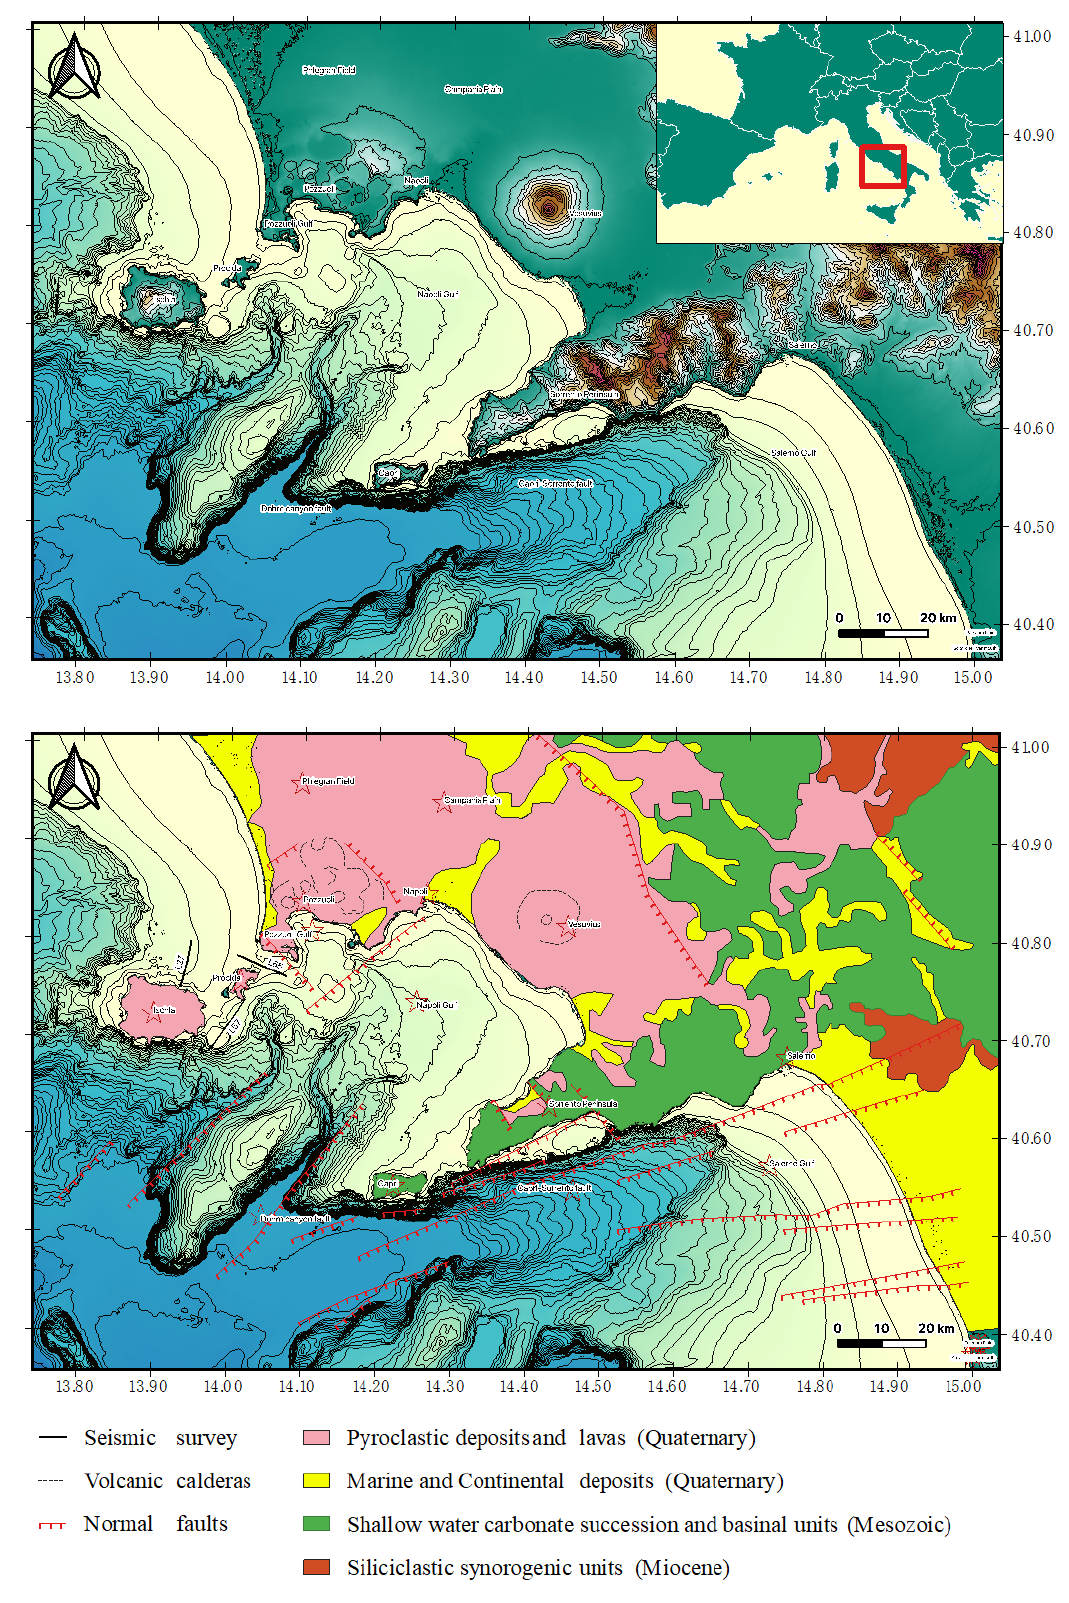
Figure 1. Study area ( top ). Sketch geologic map of the Gulf of Naples and of the adjacent Campania Plain ( bottom